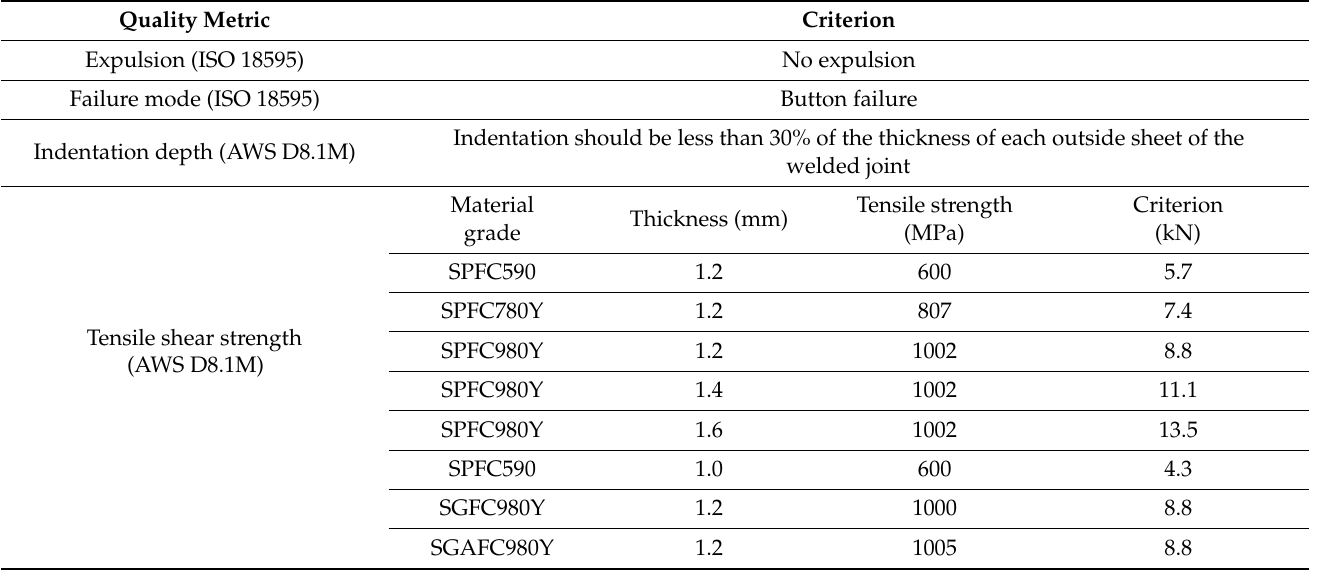
Table 11. Weld quality criterion according to quality